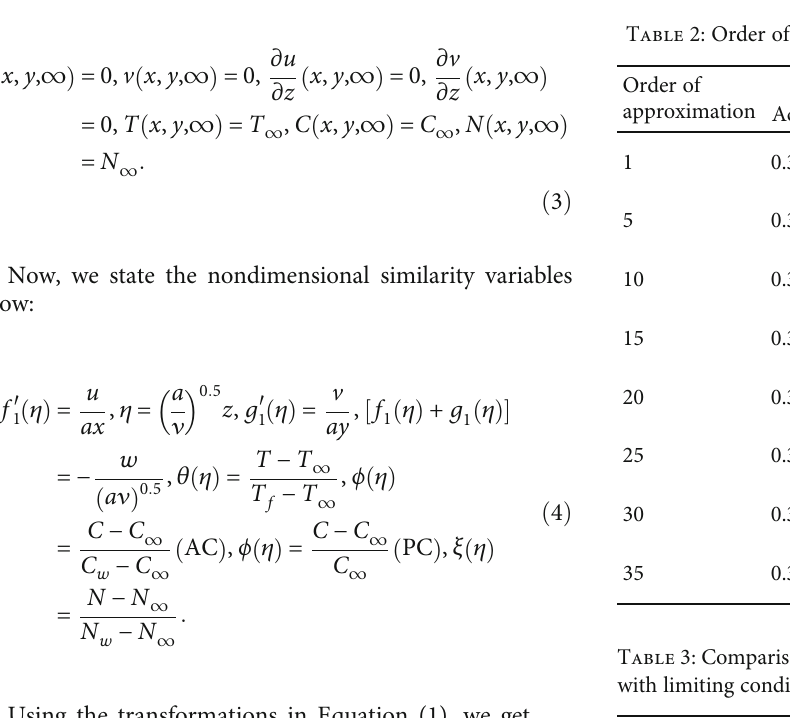
′ ð 0 Þ , − ϕ ′ ð 0 Þ , and − ξ 1 1